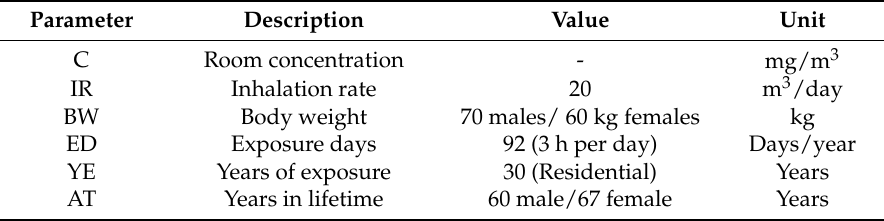
Table 1. Summary of the exposure scenario factors and values used in this